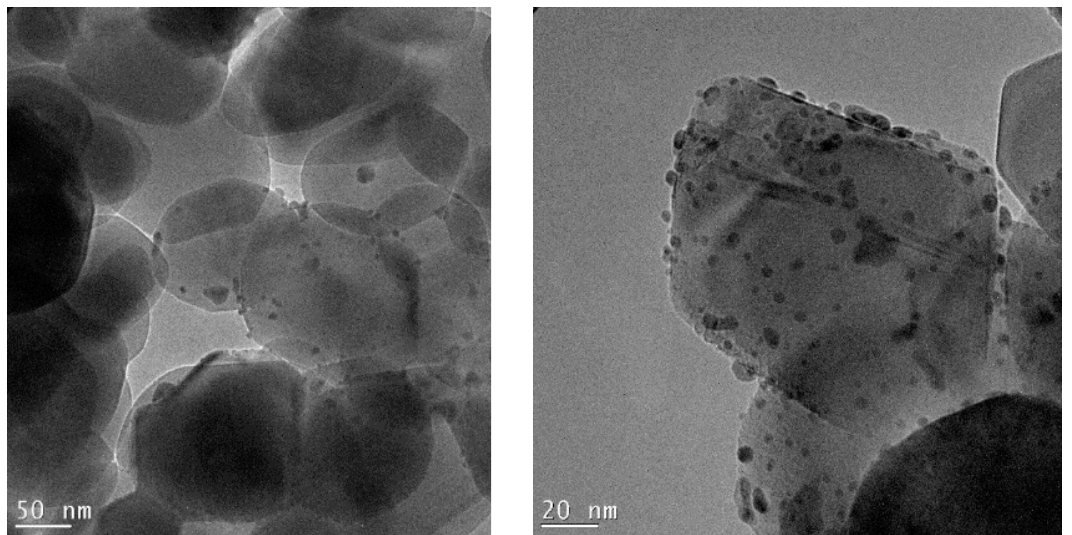
Figure 6. TEM micrographs recorded at a 38 K magnification and 97 K magnification of the 0.5%Au/3%Ag-TiO 2 catalyst.